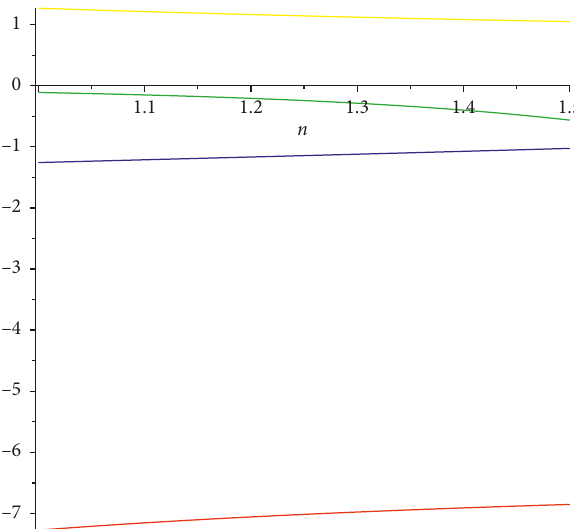
Figure 13: IRC of D